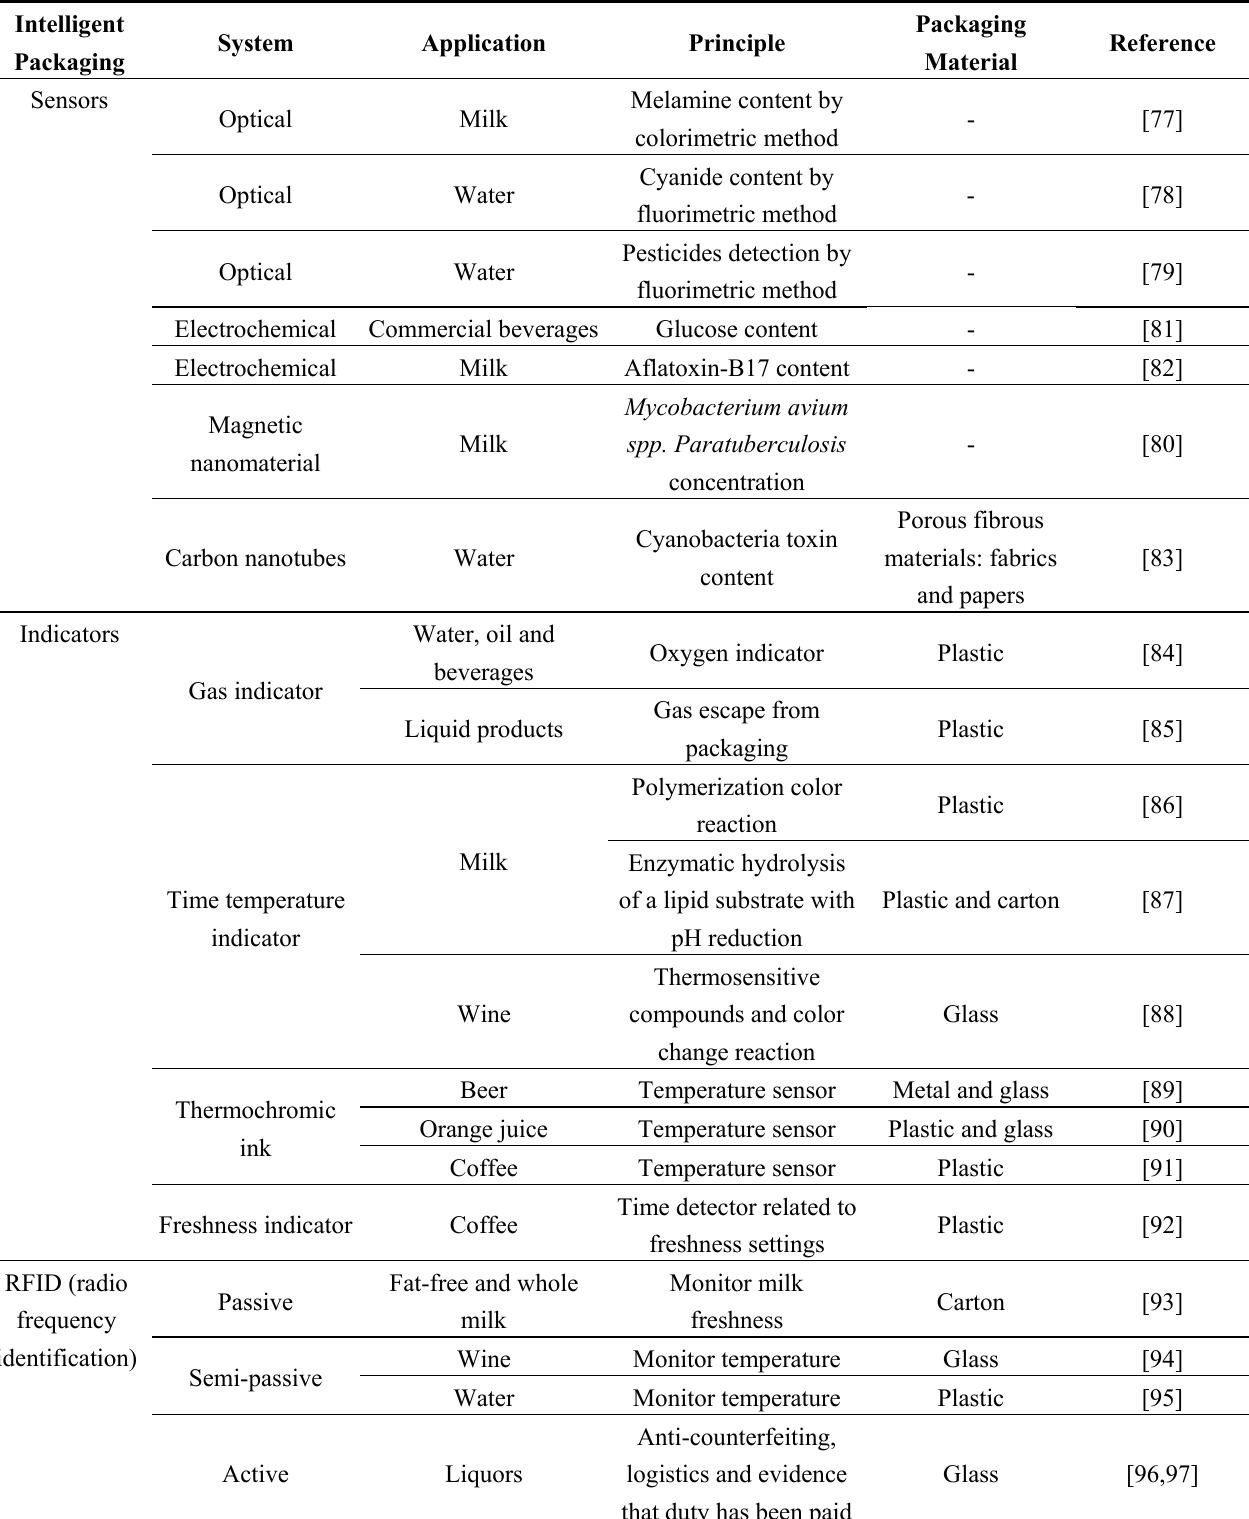
Table 3. Recent trends in intelligent beverage